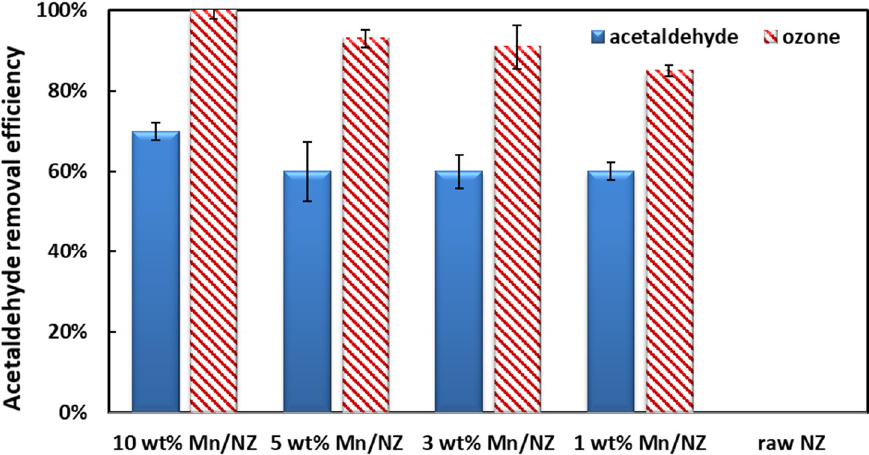
Figure 3. Acetaldehyde and ozone removal efficiencies of the Mn loaded NZ catalysts (1, 3, 5, and 10 wt.% Mn/NZ). Relative Humidity: 60%, The amount of catalysts: 1 g.